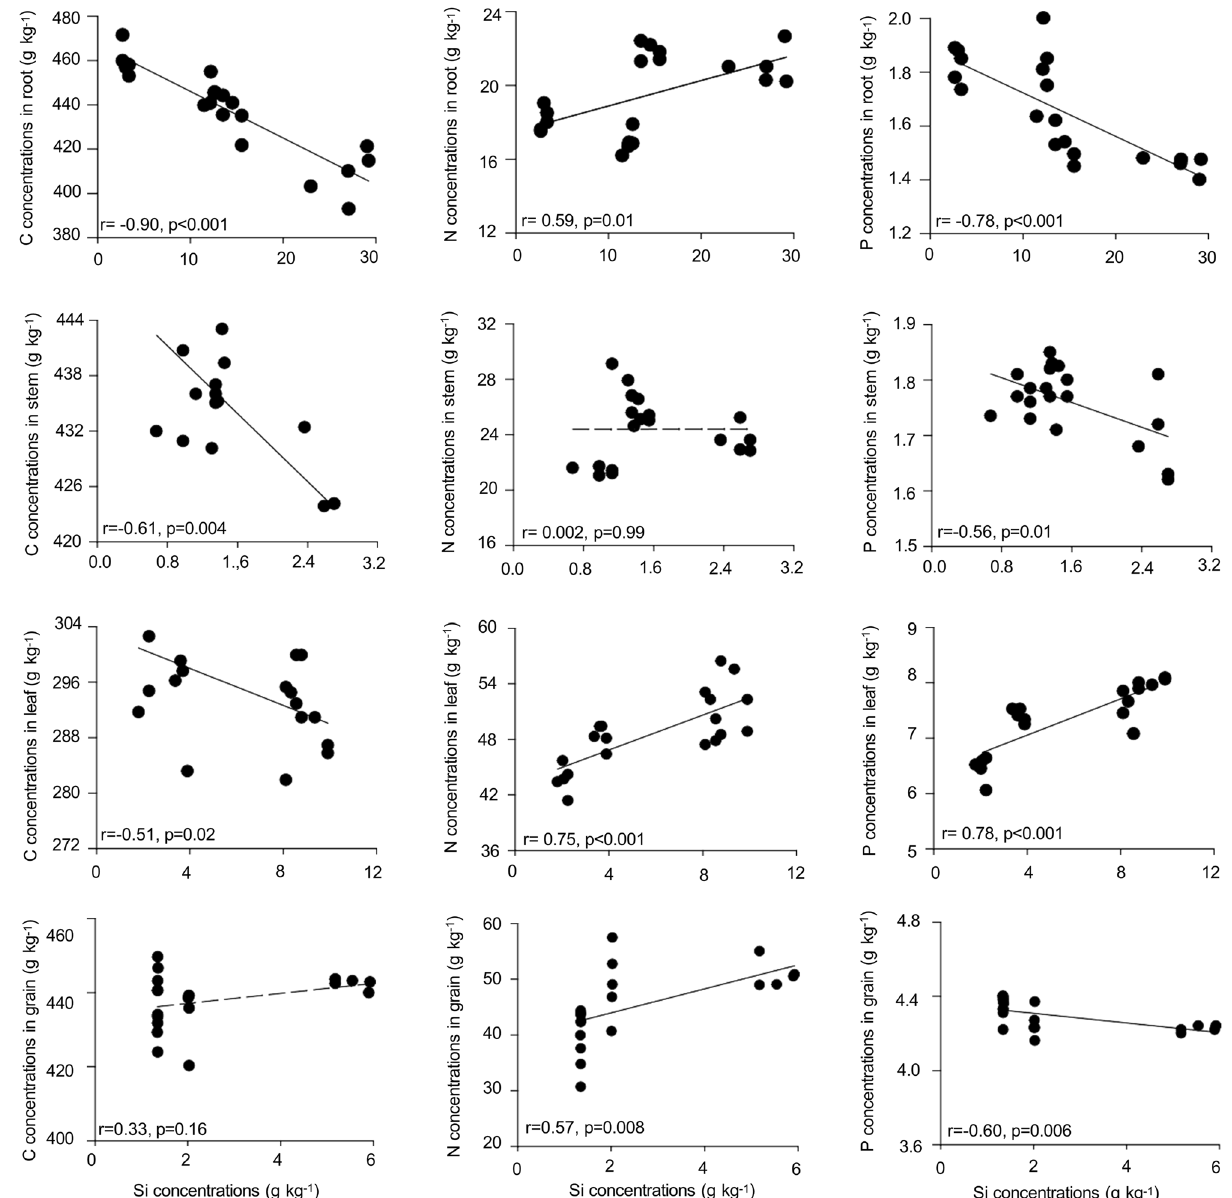
Figure 3. Correlation between Si concentrations in the root, stem, leaf, and grains of quinoa and nutrient concentrations (C, N, and P). Pearson’s correlation coefficient (r) and the p -value are shown; significant correlations ( p < 0.05) are indicated as black solid lines and non-significant correlations ( p > 0.05) as dashed